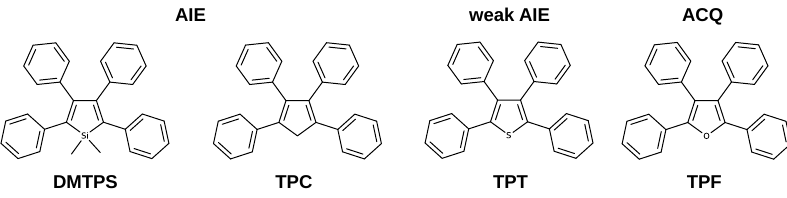
Figure 1. Structures of propeller-shaped molecules with different emissive